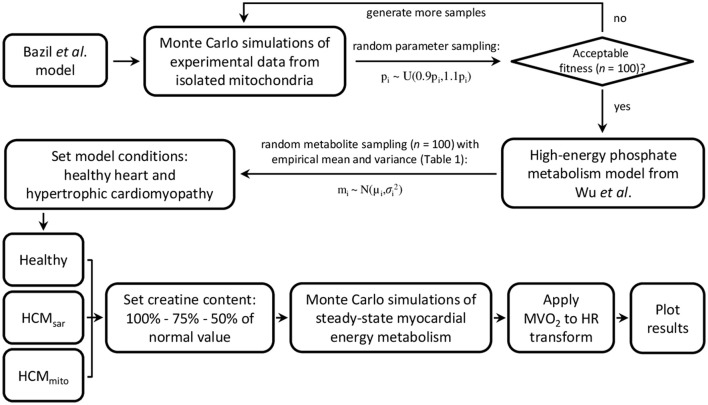
Flowchart of model parameterization and conditioning for simulations of myocardial oxidative metabolism at multiple steady-states of cardiac work rates. Bazil et al. and Wu et al. model specifics and validations are described elsewhere (Wu et al., 2008; Bazil et al., 2016). HCM, hypertrophic cardiomyopathy; HR, heart rate; MVO2, myocardial oxygen consumption.